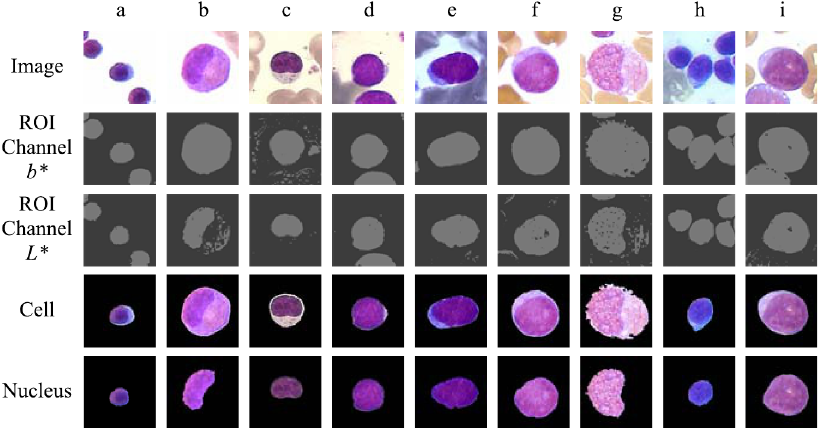
Fig 15. Examples of images segmentation with different staining and cell